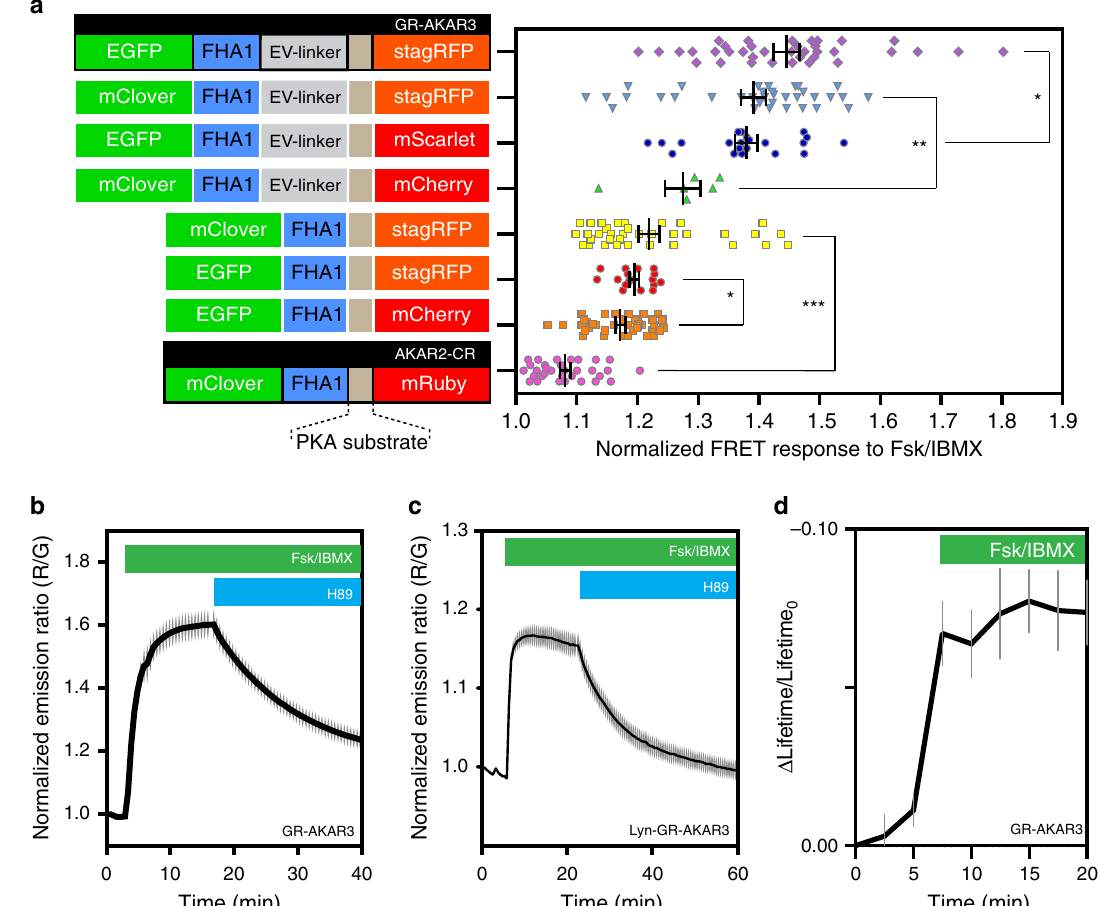
Fig. 2 Comparison highlighting the improved dynamic range of green-red A Kinase Activity Reporters (AKARs) when utilizing stagRFP. a stagRFP confers a signi fi cant increase in FRET dynamic range. The mean ± SEM is displayed. Stimulation of PKA in HeLa or HEK293T cells was performed using 50 μ M forskolin and 100 μ M IBMX, while inhibition was performed using 20 μ M H89. * p < 0.05; ** p < 0.01; *** p < 0.0001 from two tailed, unpaired Welch ’ s t -test. Speci fi cally, p values for the comparison between stagRFP and mScarlet in the AKARev context p = 0.0225 ( t = 2.349, df = 55); between stagRFP and mCherry in the mClover-AKARev context p = 0.0089 ( t = 3.239, df = 10); between stagRFP and mCherry in the EGFP-AKAR context p = 0.0430 ( t = 2.080, df = 47); and between stagRFP and mRuby in the AKAR context p < 0.0001 ( t = 15.80, df = 47). The changes in normalized emission ratio (red/green) are AKAR2-CR, 8.1 ± 0.8%, n = 32 biologically independent cells; EGFP-mCherry-AKAR, 17.2 ± 0.8%, n = 38; EGFP-stagRFP-AKAR, 19.5 ± 0.7%, n = 17; mClover-stagRFP-AKAR, 21.9 ± 1.7%, n = 35; mClover-mCherry-AKARev, 27.5 ± 2.9%, n = 6; EGFP-mScarlet-AKARev, 38 ± 1.8%, n = ( n = 8). The mean ratio ± SEM is displayed. Source data are provided as a Source Data fi le. c Membrane-targeted biosensor is able to detect the increase in membrane PKA activity ( n = 20). The mean ratio ± SEM is displayed. d The change in mean donor lifetime normalized to initial donor lifetime of GR- AKAR3 in HeLa cells upon Fsk/IBMX stimulation ( n = 6). The mean ratio ± SEM is displayed in all